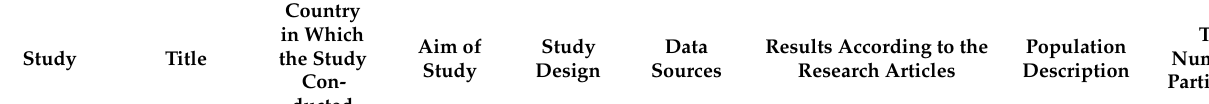
Table A2. Summary of systematic